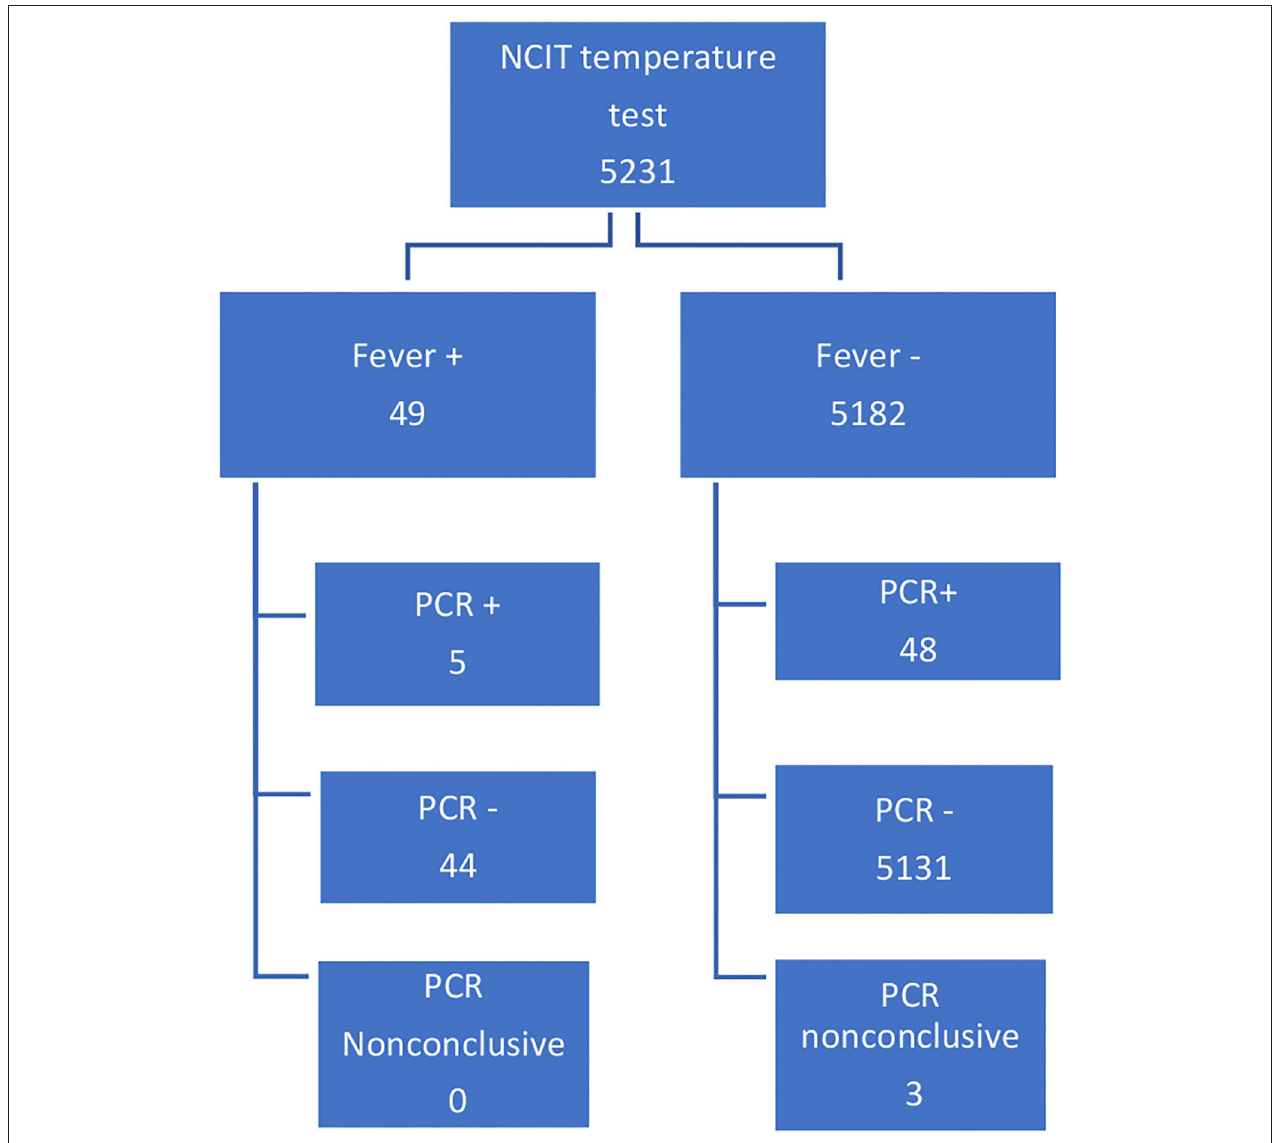
FIGURE 1 | Patients